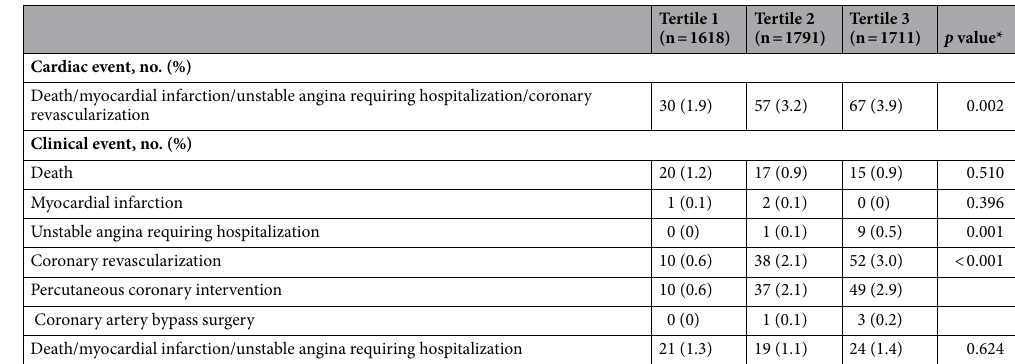
Table 4. Clinical outcomes according to the tertiles of gamma-glutamyl transferase. Values are presented as n (%). p values were calculated using the log-rank test*.